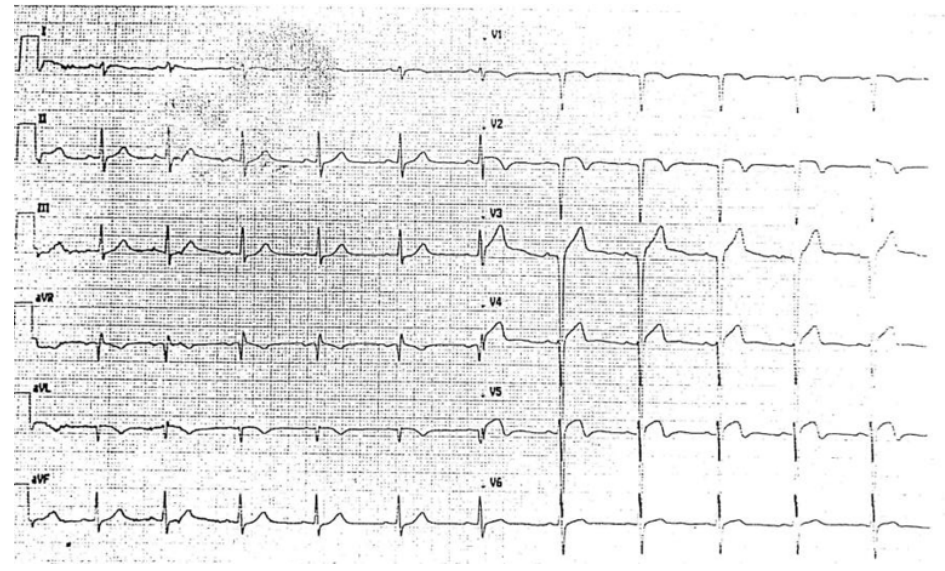
Figure 3. EKG on 3rd day after reperfusion documented QS complexes in the anterior leads and diffuse ventricular repolarization abnormalities, with preserved atrio-ventricular and intra-ventric- ular conduction.